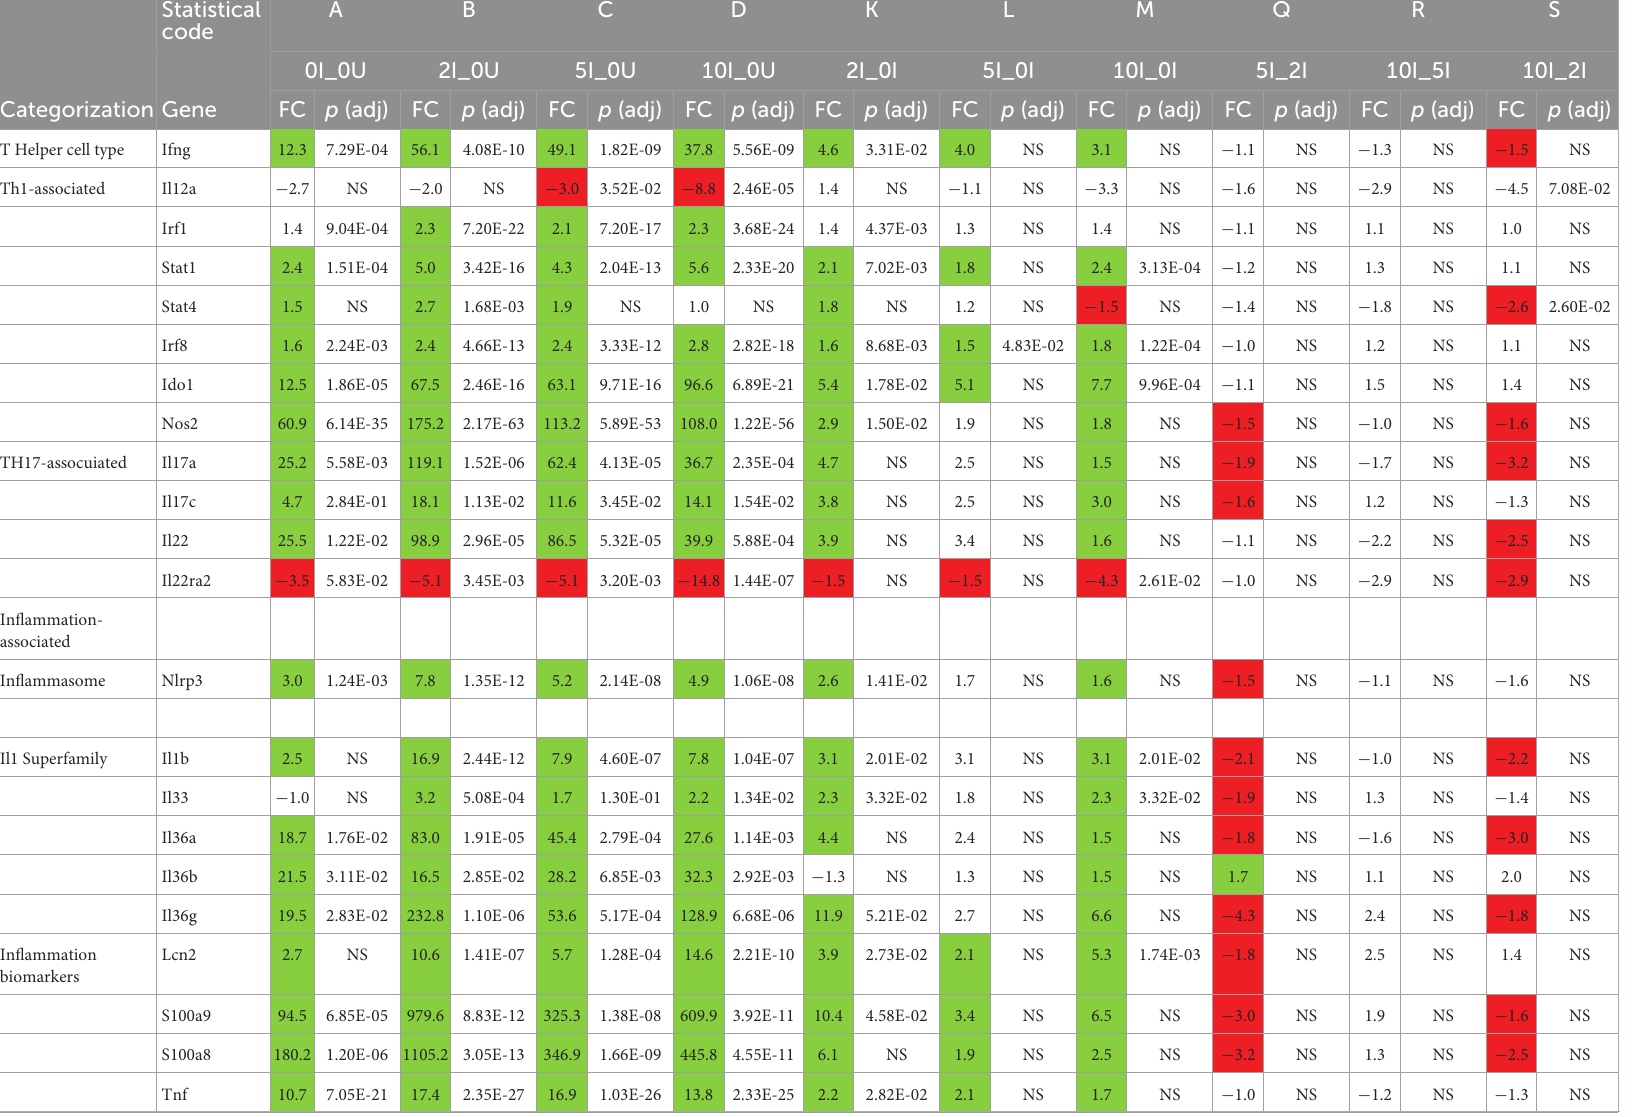
TABLE 6 Selected differentially expressed genes in the distal